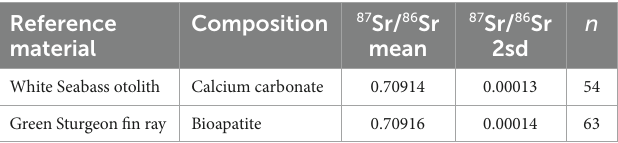
TABLE 3 In house references used to evaluate accuracy and reproducibility of LA-MC-ICP-MS. Reference